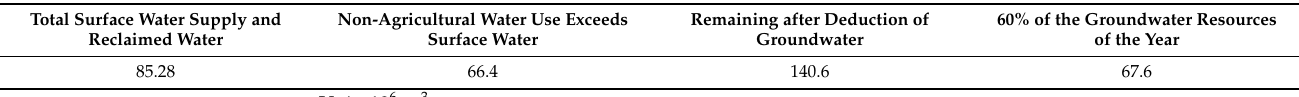
Table 7. Agricultural water consumption in Lancang County under the assumption of non- agricultural priority use of surface water in